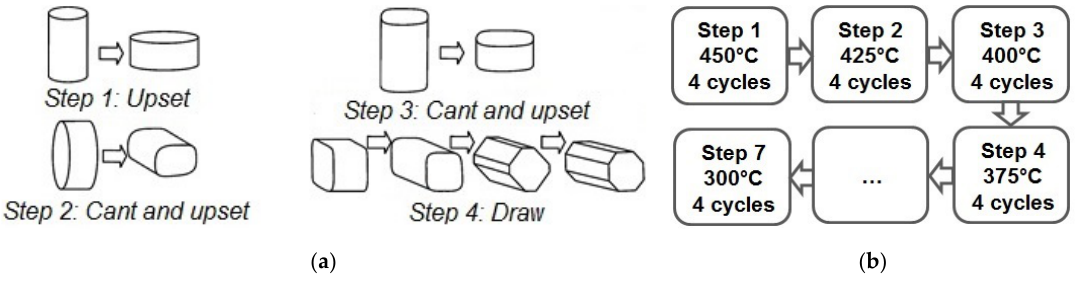
Figure 1. Schematics of multiaxial deformation process ( a ) and the processing schedule ( b ).